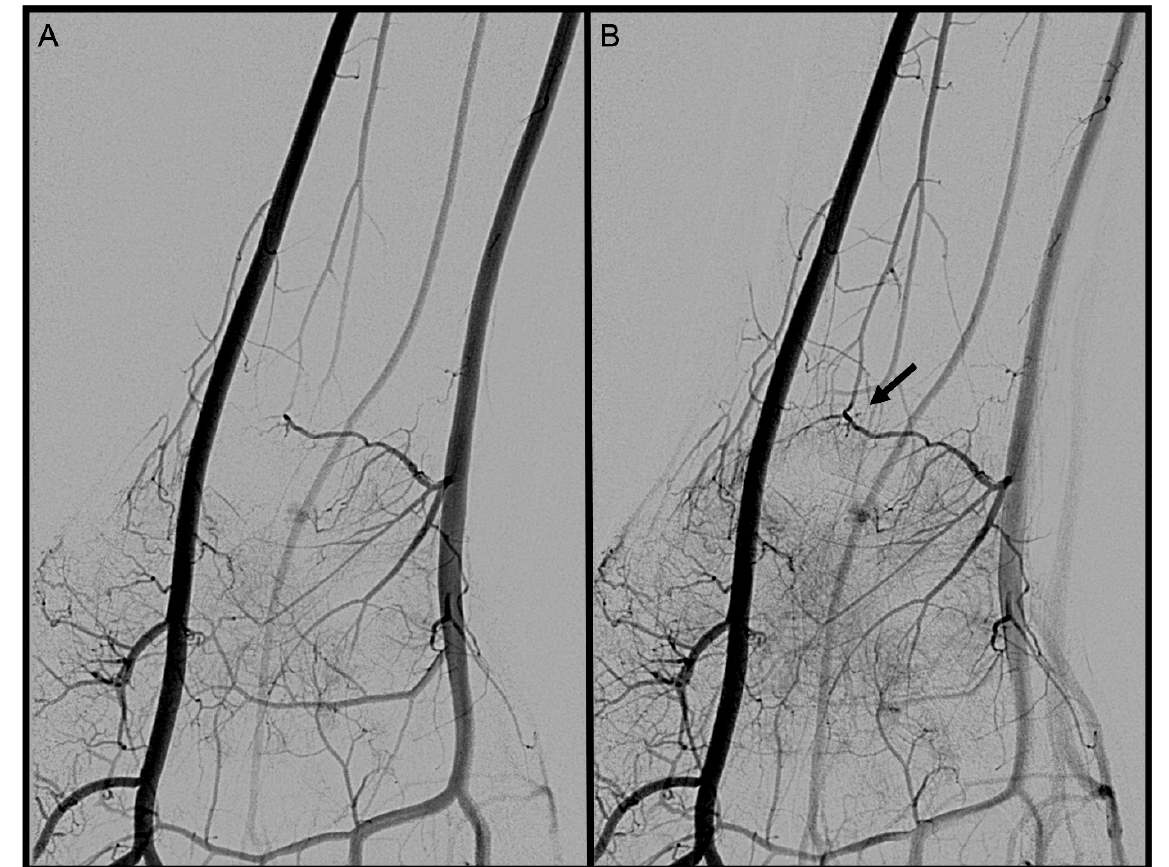
Figure 9. Palmo-dorsal angiography run of the wrist. ( A ): PRCA before anastomosis becomes visible. ( B ): The (cid:212) shows the “L-shaped” anastomosis between the PRCA and the AIA (PRCA = palmar radiocarpal arch; AIA = anterior interosseous artery).